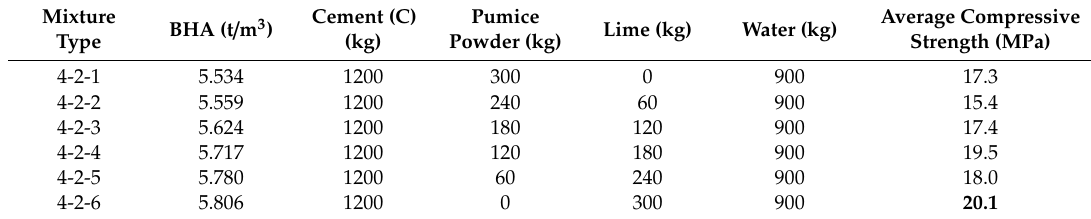
Table 26. Type-2 mixture quantity, weight per unit of volume and compression test results.